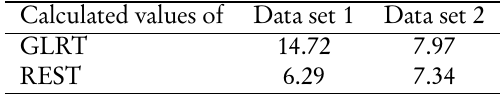
The computed values of the statistic for GLRT and REST for MYD.